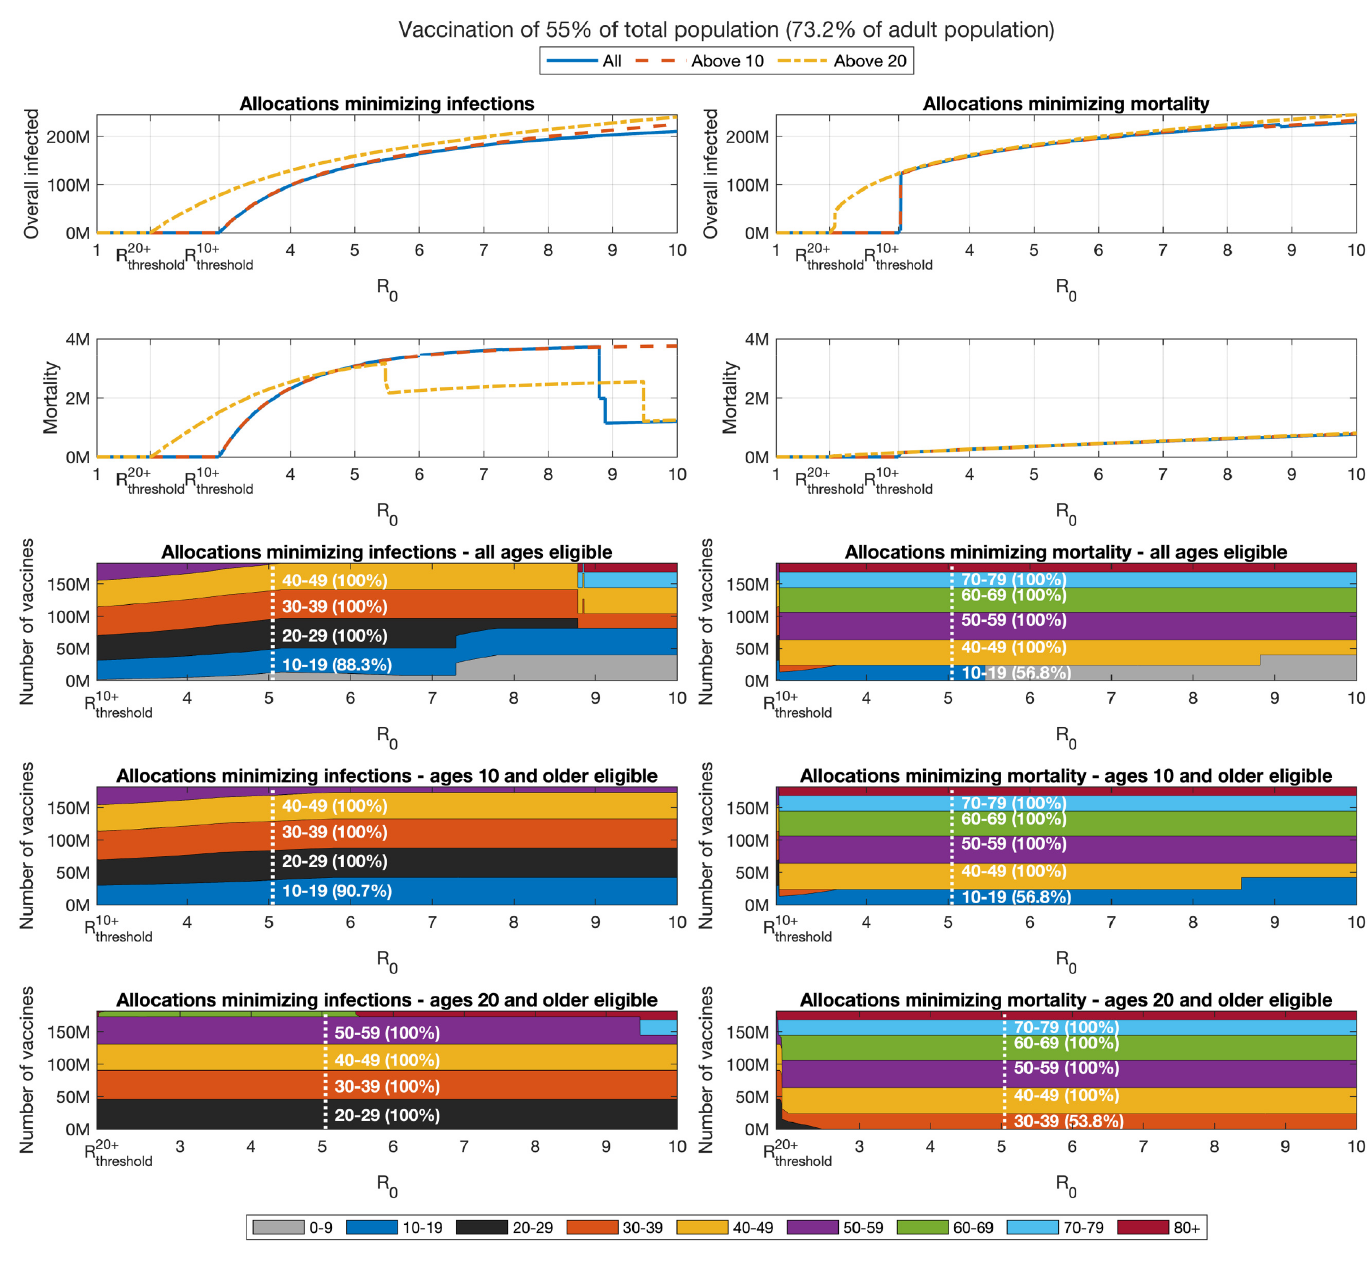
Fig 4. Impact of change in reproduction number. Overall infections of non-vaccinated individuals (top graphs) and overall mortality (centered graphs) as function of the basic reproduction number R 0 after completion of a vaccination campaign for allocations minimizing infections (left panels) and allocations minimizing mortality (right panels). The outcomes are presented for the following cases: All ages are eligible for vaccination ( solid ), only ages 10 and older are eligible ( dashes ), and only ages 20 and older are eligible ( dash (cid:0) dots ). Bottom panels present the corresponding